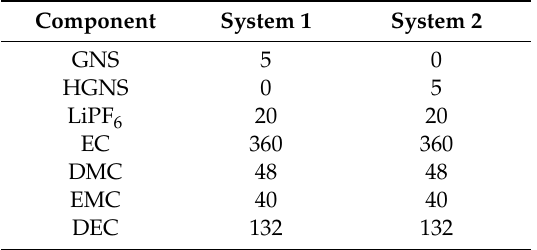
Table 2. Simulation conditions of the two